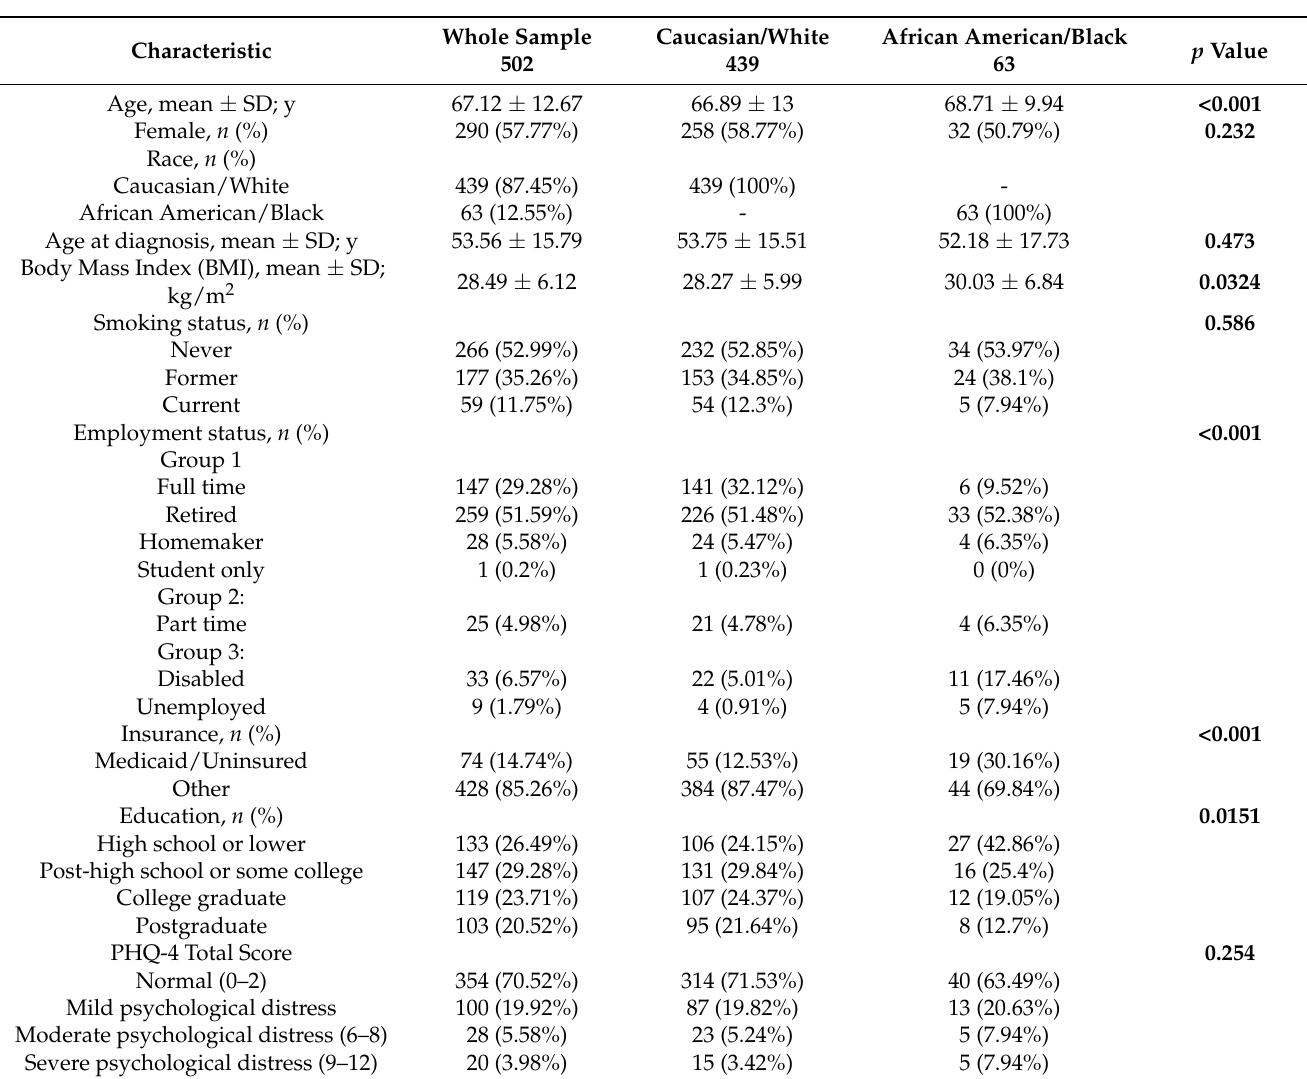
Table 1. Baseline characteristics of